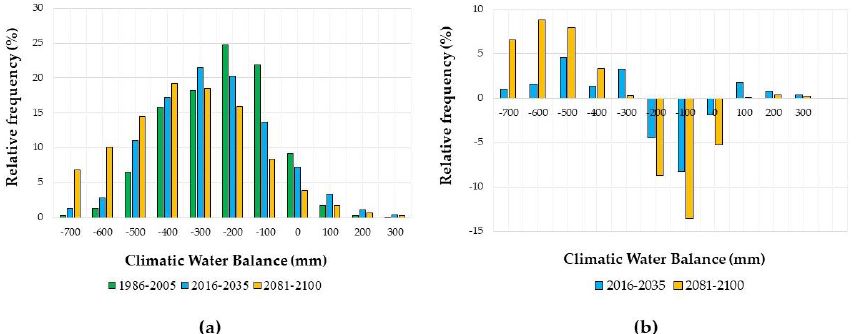
Figure 5. Frequency distribution of the climatic water balance (CWB) in Hungary during the growing season in the three investigated periods ( a ) and changes of these frequencies from the 1986–2005 reference period to the near (2016–2035) and distant (2081–2100) future periods ( b ).